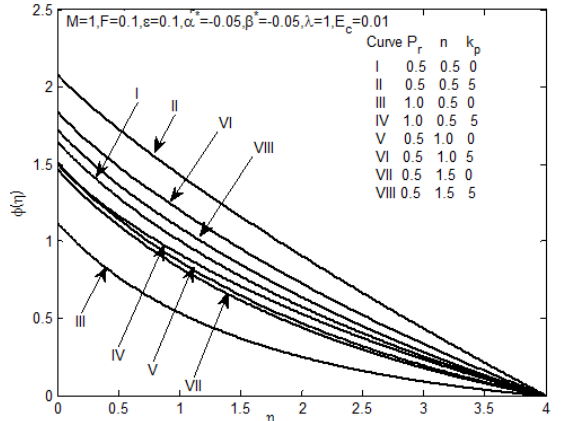
Figure 17: Temperature profiles (PHF case)